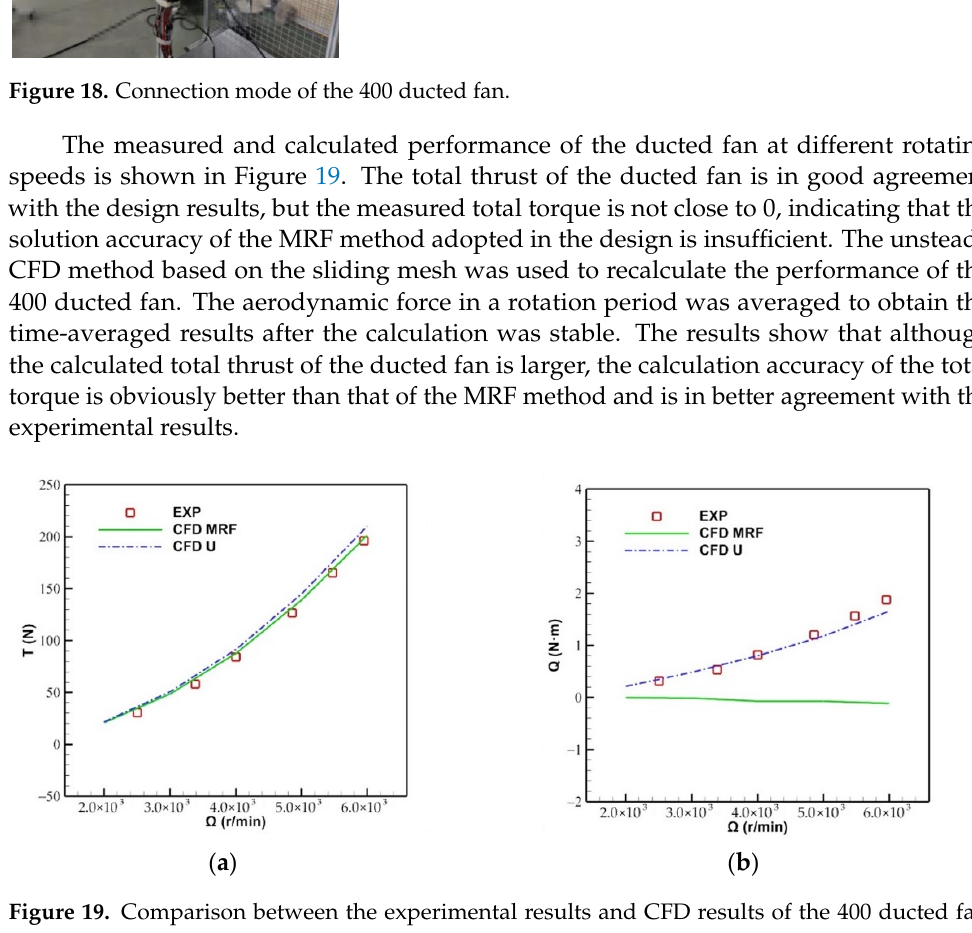
Total thrust, ( b ) total torque.× ( a )